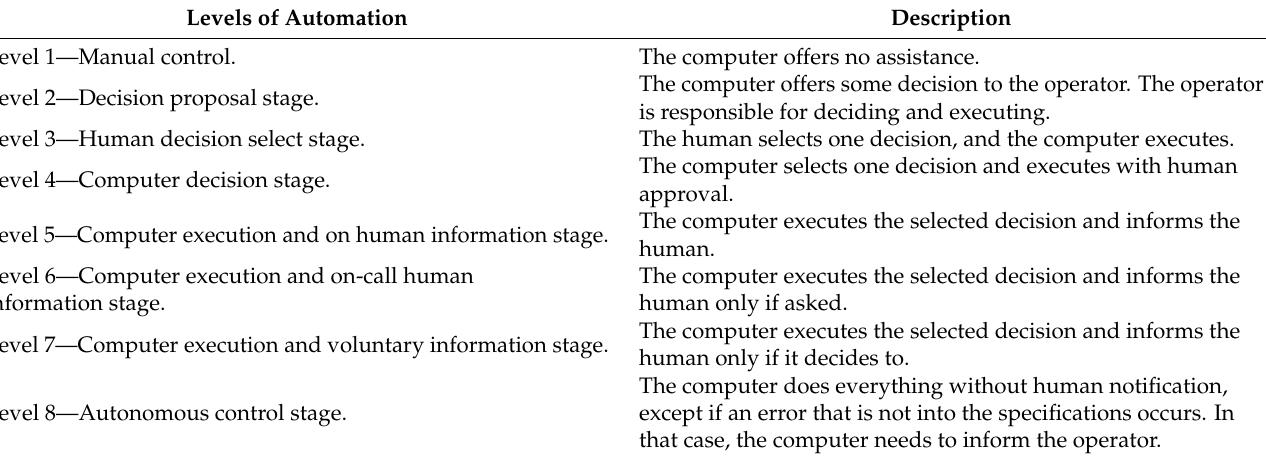
Table 1. A taxonomy for the levels of autonomy (Adapted from Vagia et al. [38]). Levels of